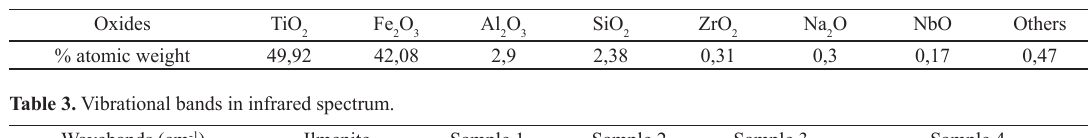
Table 2. Most stable oxides found in ilmenite.